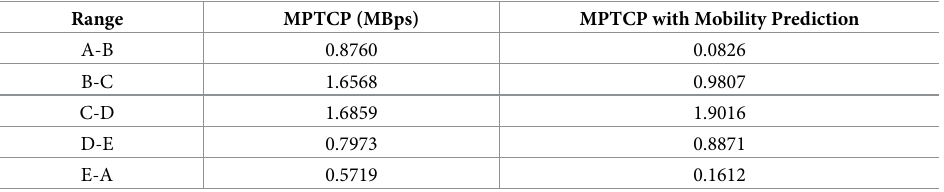
Table 2. Average throughput of MPTCP and MPTCP with mobility prediction in each